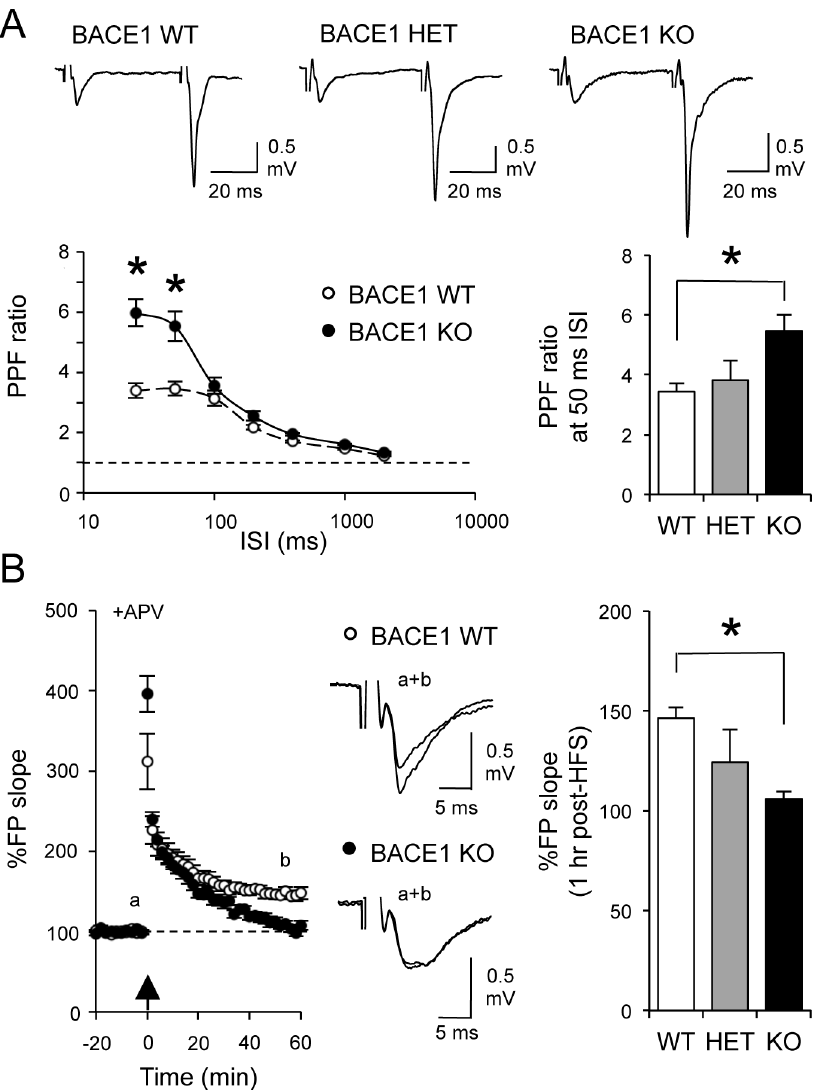
Figure 1. Abnormal synaptic function at MF to CA3 synapses in young BACE1 KOs. (A) Young BACE1 KOs (black circles) displayed larger PPF ratio (especially at 25 and 50 msec ISIs) compared to WTs (white circles). Top panel: Representative field potential traces following paired-pulse stimulation at 50 msec ISI. *P , 0.001, two-way ANOVA; Fisher’s PLSD post hoc test P , 0.001 between the two genotypes. Bottom right: BACE1 heterozygotes (HET) showed an intermediate phenotype between WT and KO at 50 msec ISI (one-way ANOVA, P , 0.02; Dunnett’s multiple comparison test: *P , 0.05 compared to WT). (B) Absence of mossy fiber LTP in young BACE1 KOs. Left: Summary graph plotting changes in normalized field potential against time. The arrow depicts when HFS (100 Hz, 1 sec 6 3) was delivered. Note that KOs (black circles) showed no LTP 60 minutes after LTP induction compared to WTs (white circles). Middle: Superimposed representative field potential traces taken from WTs and KOs at times indicated in the left panel. Right: BACE1 HETs showed an intermediate level of mfLTP (one-way ANOVA, P , 0.02; Dunnett’s multiple comparison test: *P , 0.05 compared to WT).